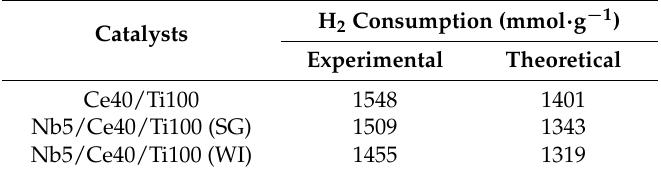
Table 5. H 2 consumption calculated from temperature-programmed reduction (TPR).